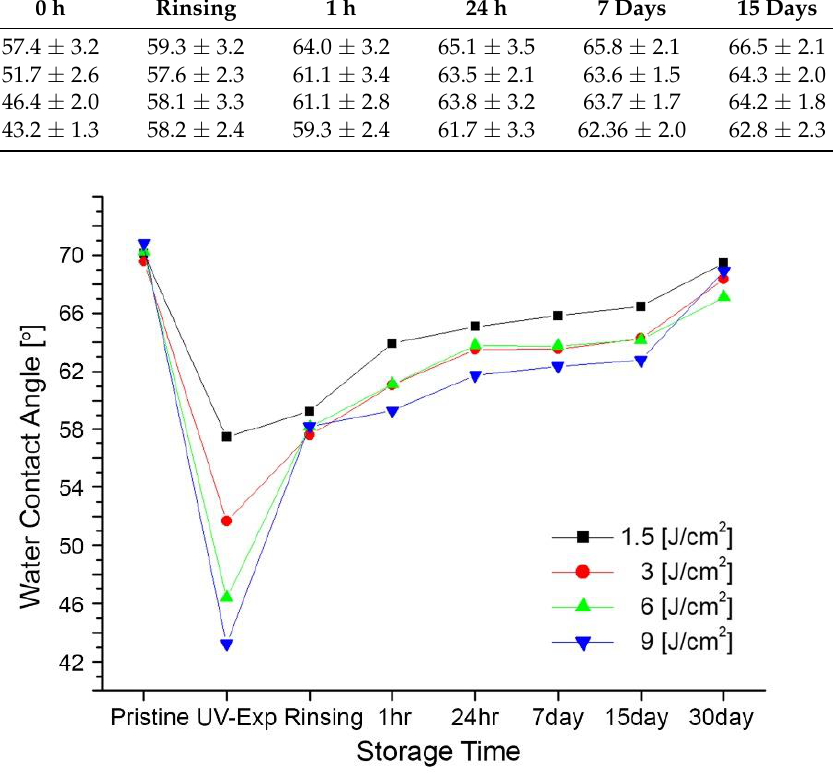
Figure 7. Average change in water contact angles of PMMA surface by storage time after UV-exposure for IPA-rinsed PMMA sheets.